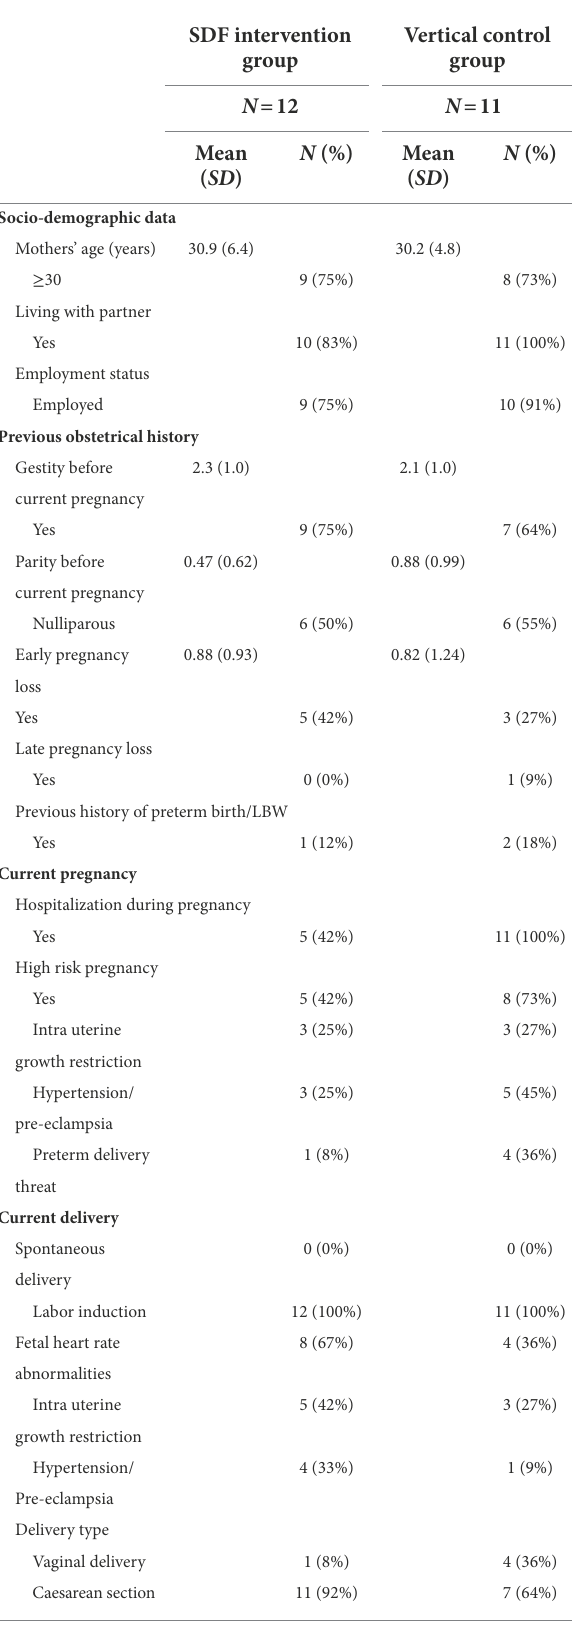
TABLE 2 Sociodemographic, previous obstetrical, and delivery data according to SSC positioning. SDF intervention Vertical control group